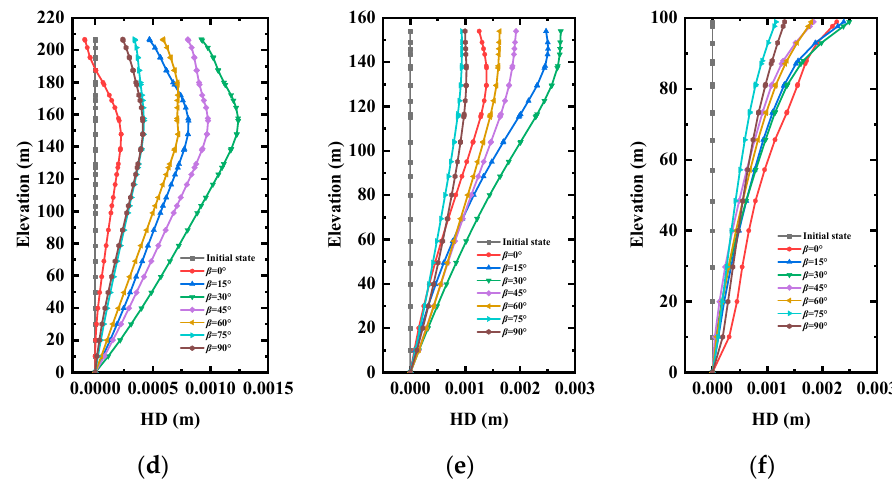
Figure 9. Horizontal displacement levels at different positions on the layered rock slope under different β values with k r = 0.01 and k r = 0.1: ( a ) Top of the slope with k r = 0.01; ( b ) middle of the slope with k r = 0.01; ( c ) middle of the slope with k r = 0.01; ( d ) top of the slope with k r = 0.1; ( e ) middle of the slope with k r = 0.1; ( f ) bottom of the slope with k r = 0.1.